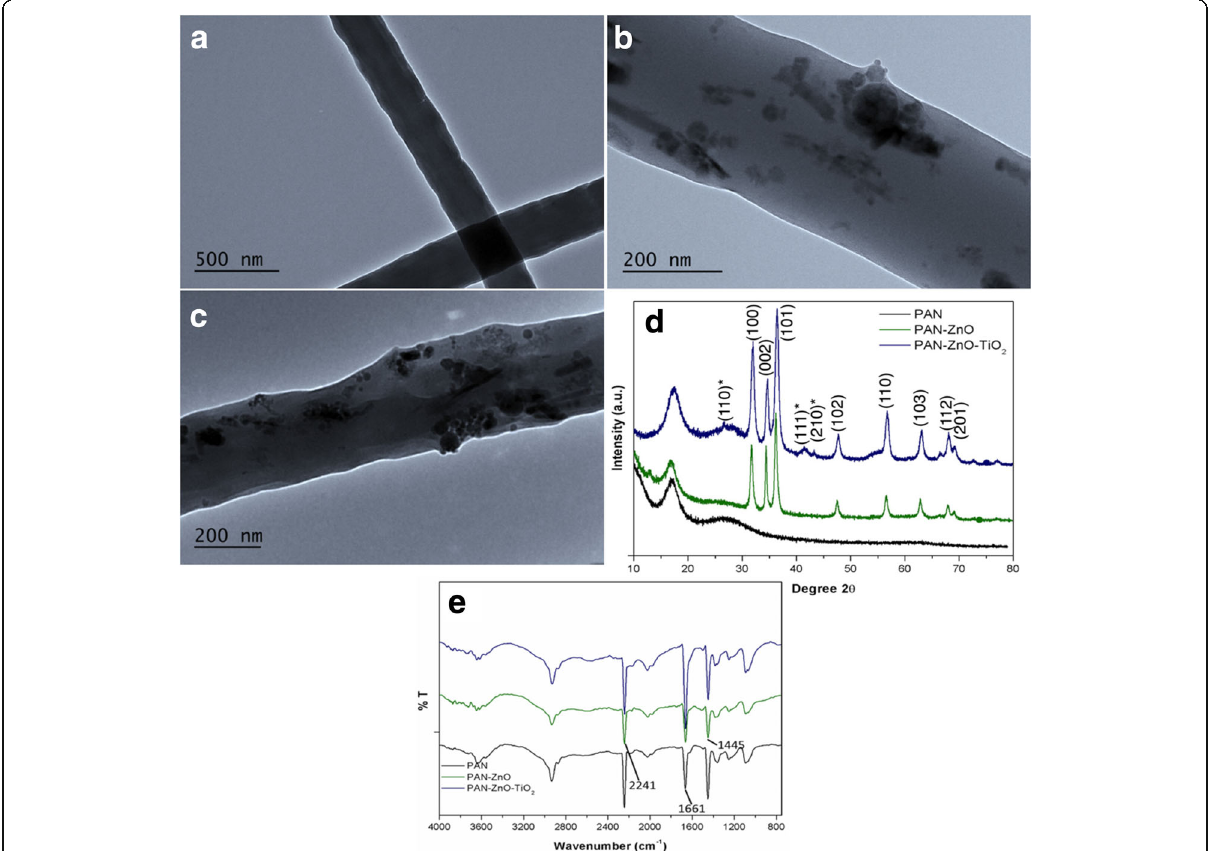
Fig. 4 Representing TEM images of a PAN n- fib@Mat, b PAN-ZnO n- fib@Mat, c PAN-ZnO-TiO 2 n- fib@Mat, and d XRD pattern of ZnO and TiO 2 - ZnO nanoparticles immersed in n- fib@Mat. e FT-IR spectra of PAN n -fib@Mat, PAN-ZnO n -fib b Mat, and PAN-ZnO-TiO 2 n